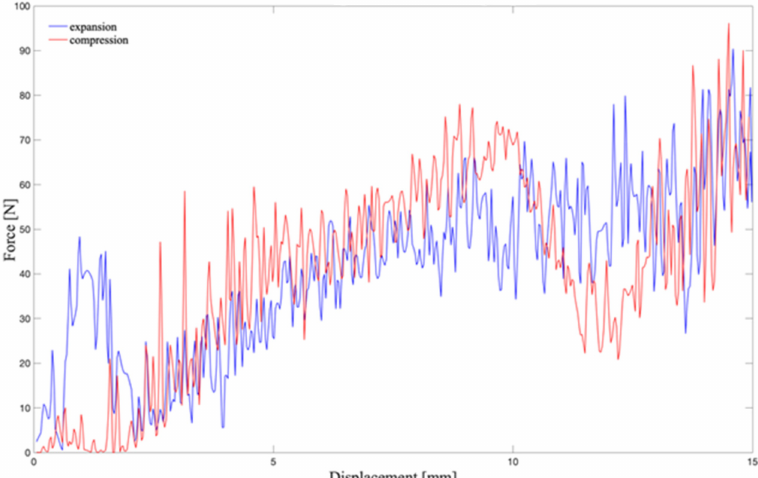
Figure 11. Force vs. displacement curve: its integration gives the work that the plate has to develop to compress the chamber. The red line shows the calculated force during the compression of the chamber; the blue line represents the force during the expansion, from 15 mm to the initial